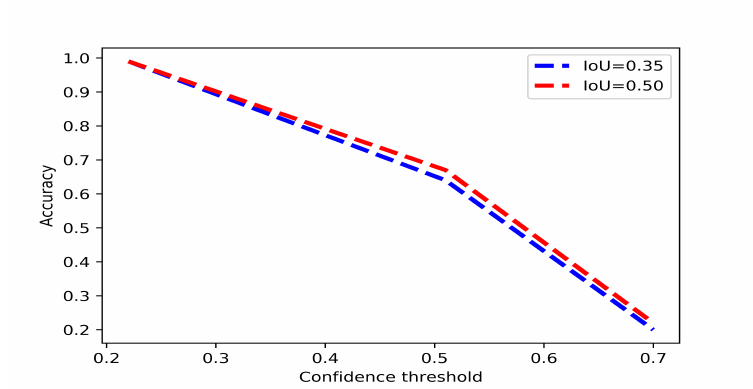
Figure 9. Evaluation of confidence threshold and IoU impacts on the